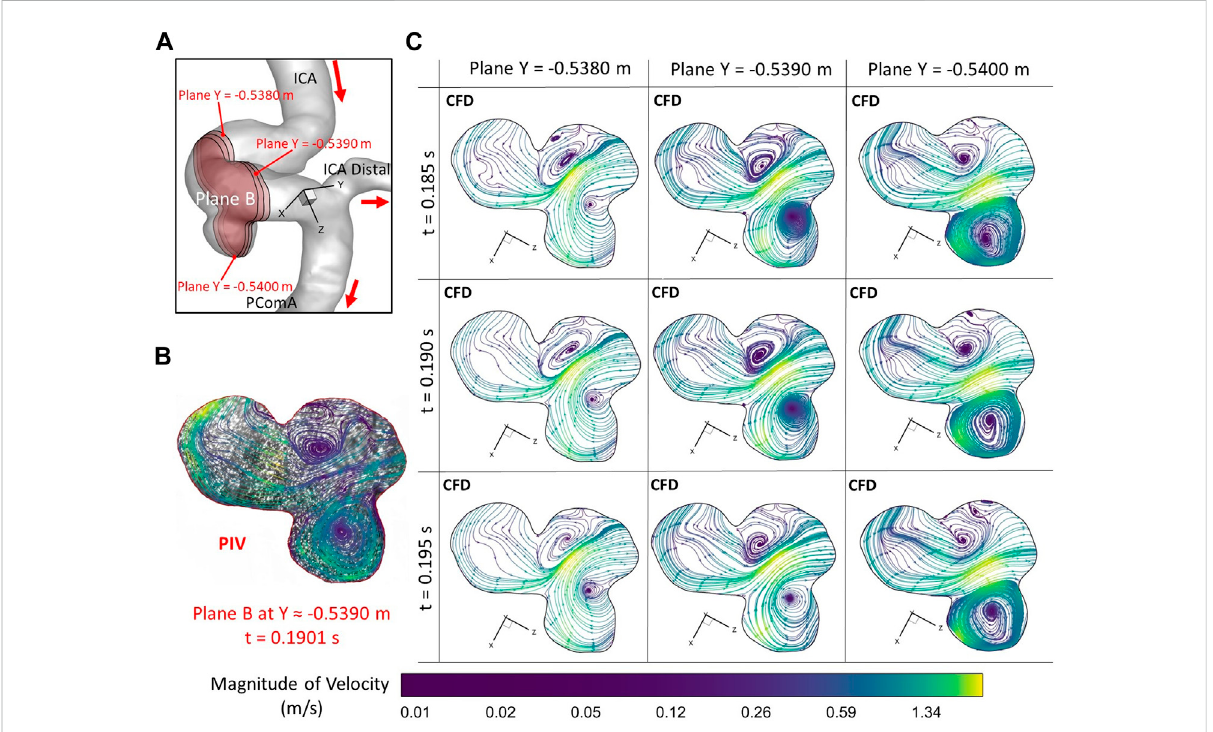
FIGURE 7 Comparisonsof fl ow streamlinesand magnitudes of velocity atthe extracted plane B (i.e., plane Y ≈ − 0.5390 m according to the coordinatesin CFD) between PIV measurements and CFD simulations at the time instant t = 0.1901 s: (A) Schematic planes for the comparisons between PIV and CFD. (B) Distributions of fl ow streamlines and magnitudes of velocity in PIV. (C) Distributions of fl ow streamlines and magnitudes of velocity in